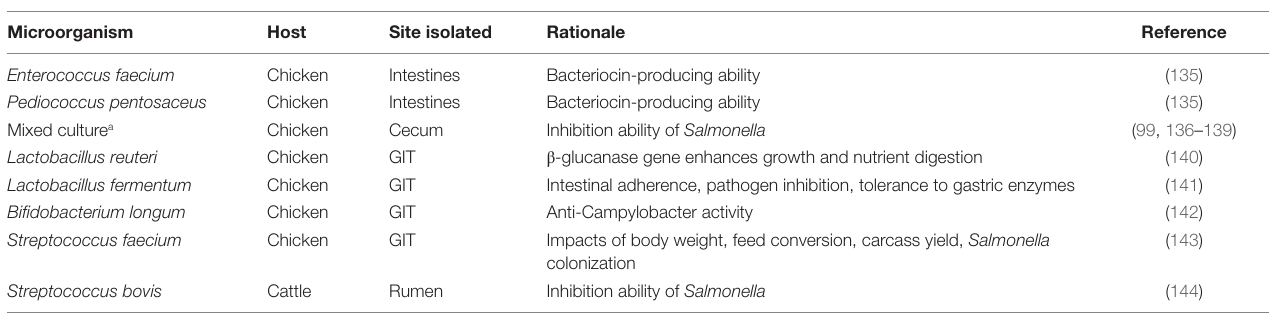
TABLe 3 | Suggested microorganisms for potential probiotic use based on various characteristics.